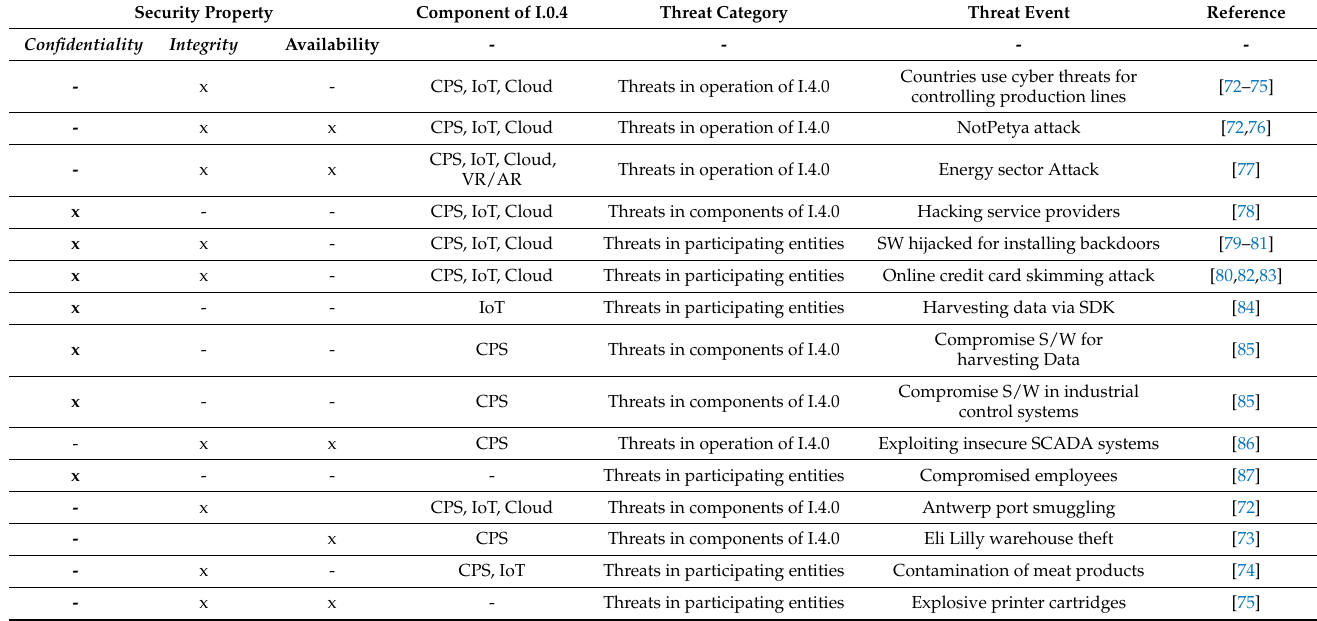
for each threat incident which security property is affected and in which category it belongs. Table 2. Categorization of Reported Threats Events in